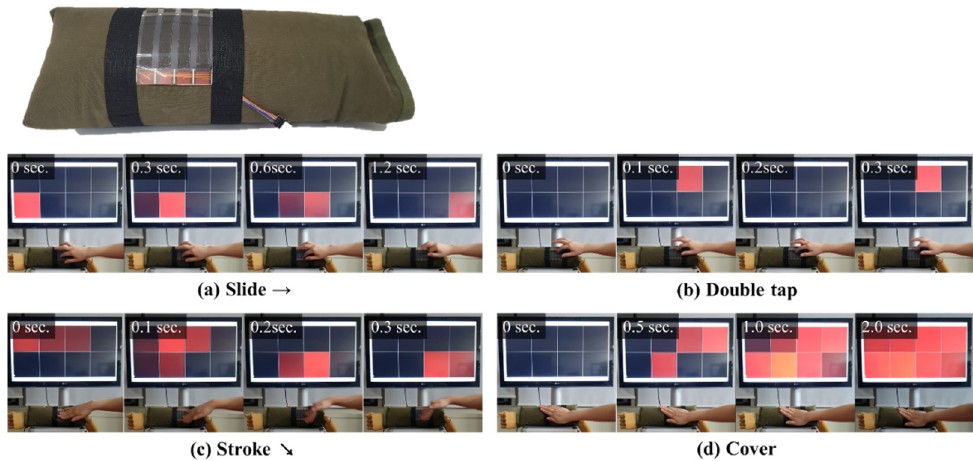
Figure 7. Touch sensing images of the airbag skin prototype at various dynamic pressure.